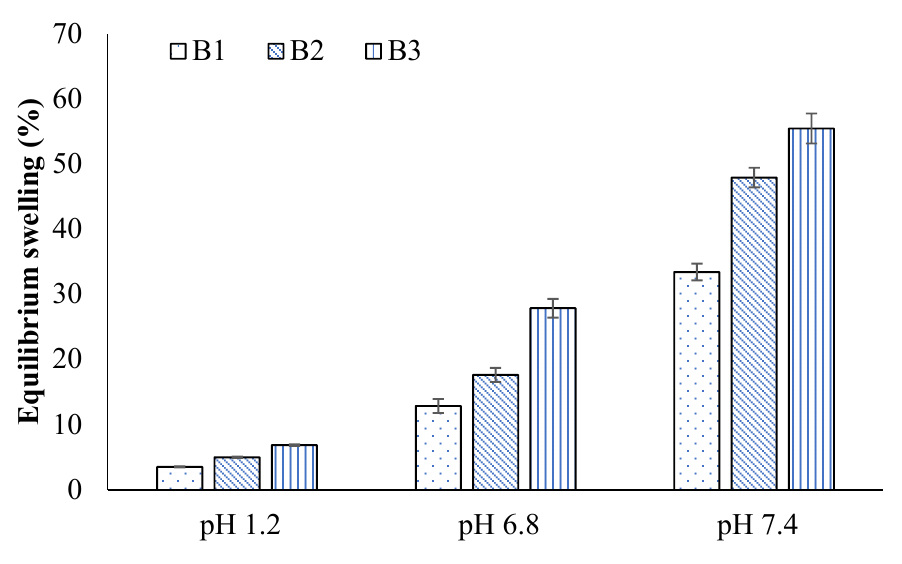
Figure 4. Effect of AA on dynamic swelling of 5-FULH.